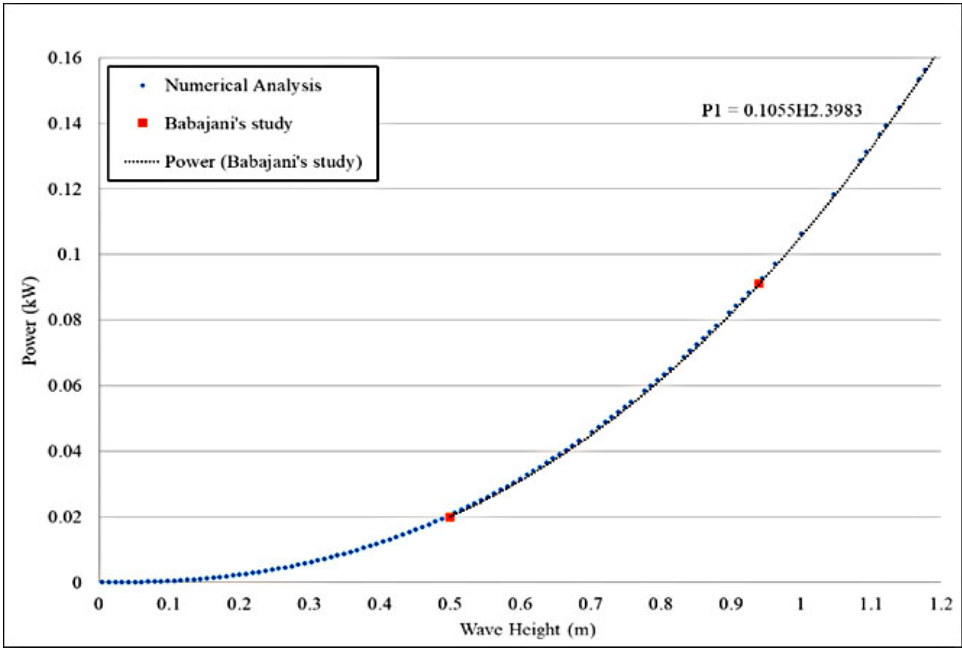
Figure 12. The change of Searaser produced power with wave height.